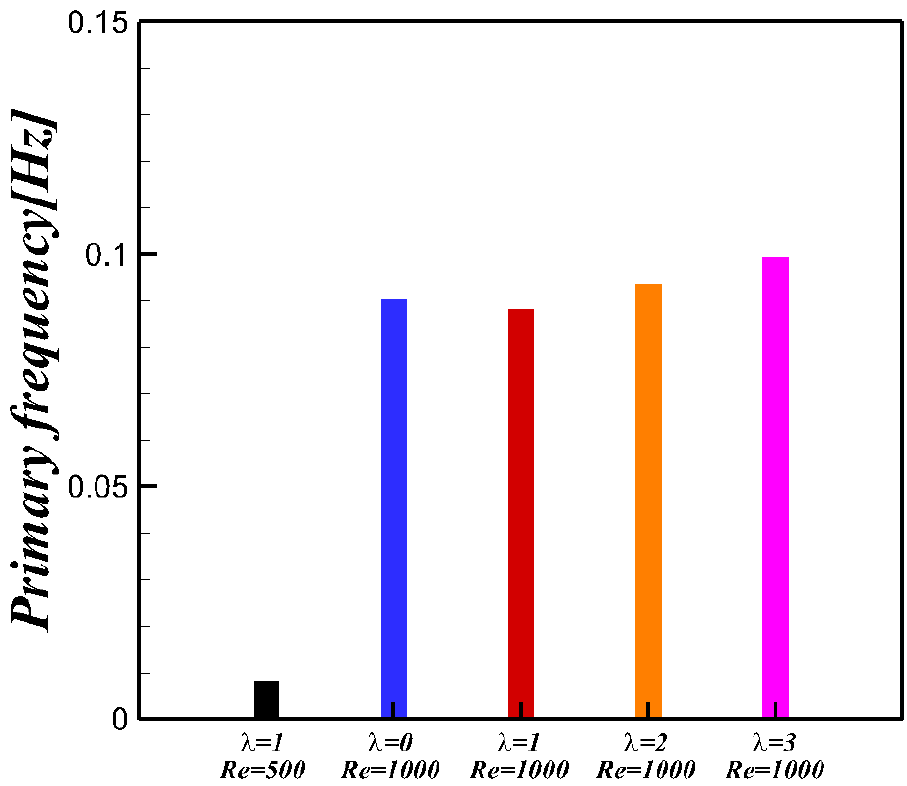
Figure 8. Primary frequency distribution of the surface-averaged Nusselt number for the heated bottom wall.